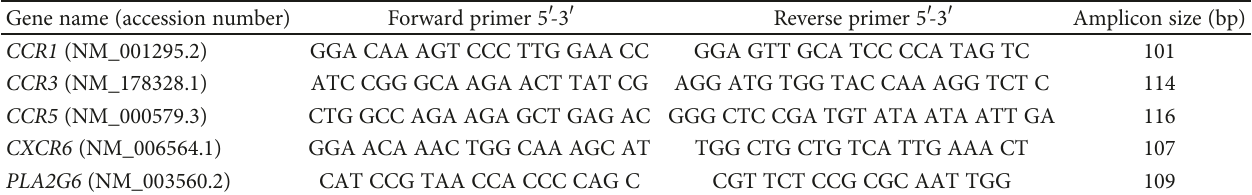
Table 1: List of primers used for real-time